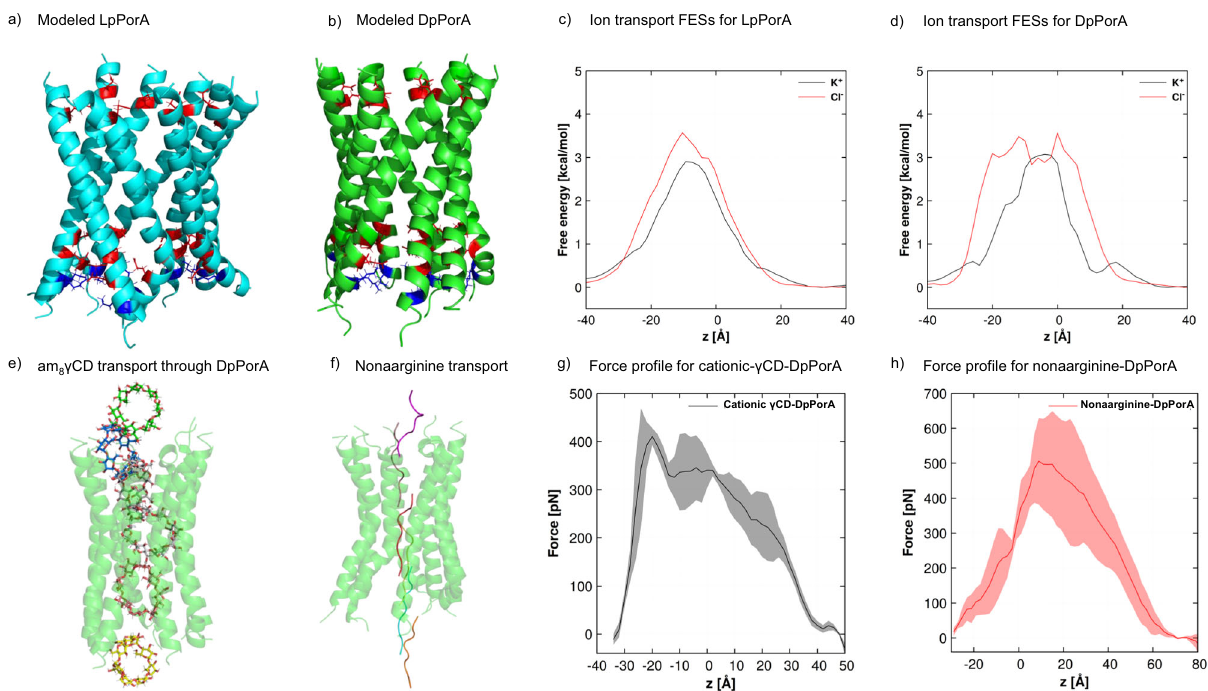
d 1D multi-ion FESs for DpPorA. e Transport of am 8 γ CD through DpPorA and f Nonaarginine transport through DpPorA. Average force pro fi le from steered MDsimulationforthepermeationof g am 8 γ CDand h nonaarginineasafunction of reaction coordinate z, i.e., the center of mass distance between am 8 γ CD or nonaarginine and the C α atoms of DpPorA and the shaded error bars represent the standard